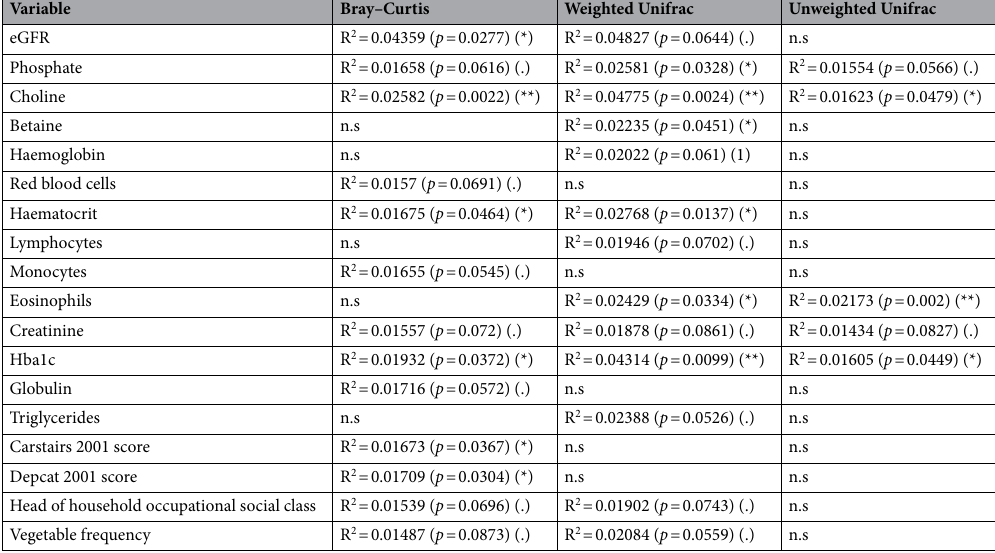
Table 2. PERMANOVA analysis showing significant sources of variation (metadata) in microbial community structure (distances between samples) with R 2 representing percentage variability if significant for that variable. For example, R 2 = 0.02581 for phosphate implies 2.5% variability. Asterisks denote a statistically